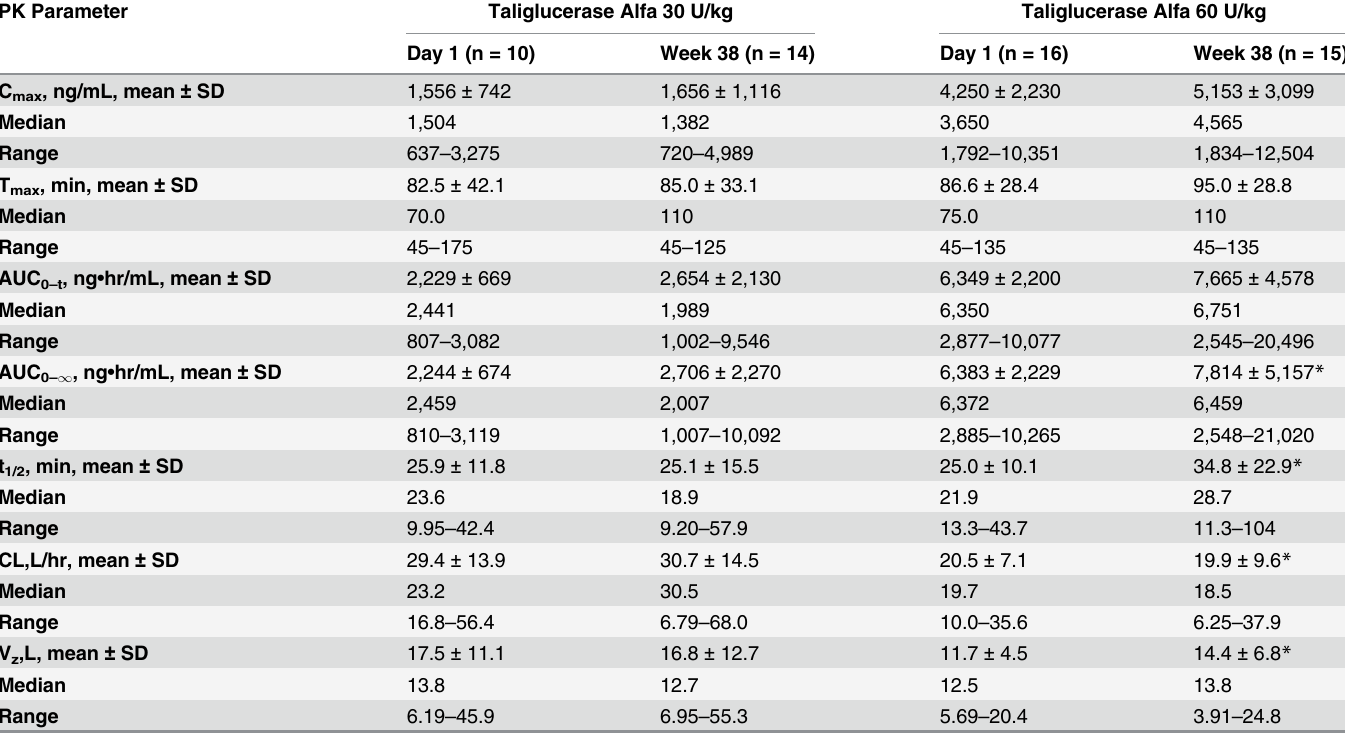
Table 2. Summary of PK parameters of taliglucerase alfa in adult